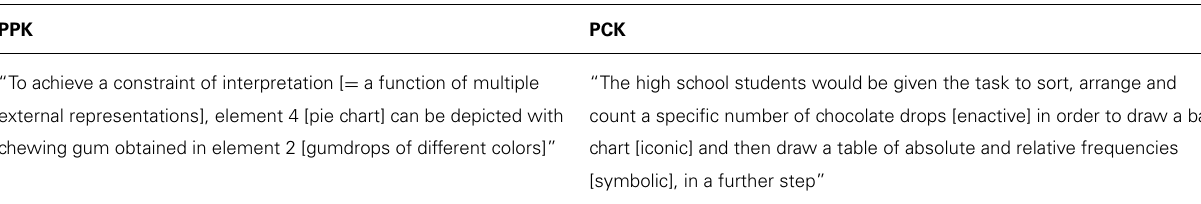
Table 2 | Exemplary excerpts of student answers coded as PPK and PCK aspects. PPK PCK